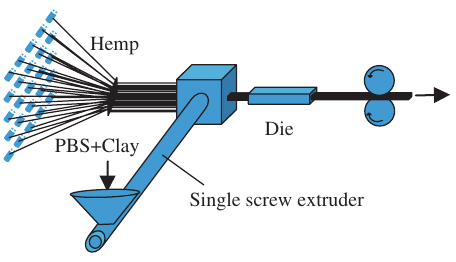
Figure 1 Schematic drawing of pultrusion